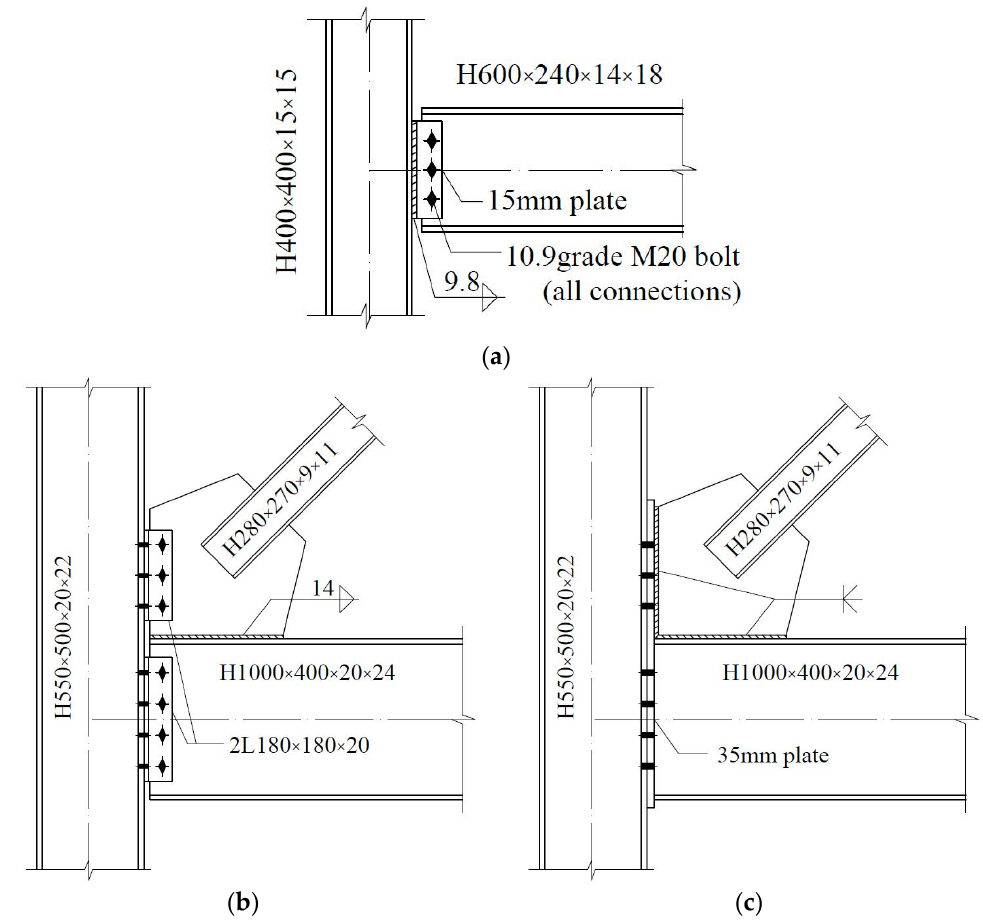
Figure 3. Connection details: ( a ) shear-tab connation; ( b ) double-angle connection; ( c ) end-plate connection (unit: mm). Table 3. Connection-type summary of CBF models.